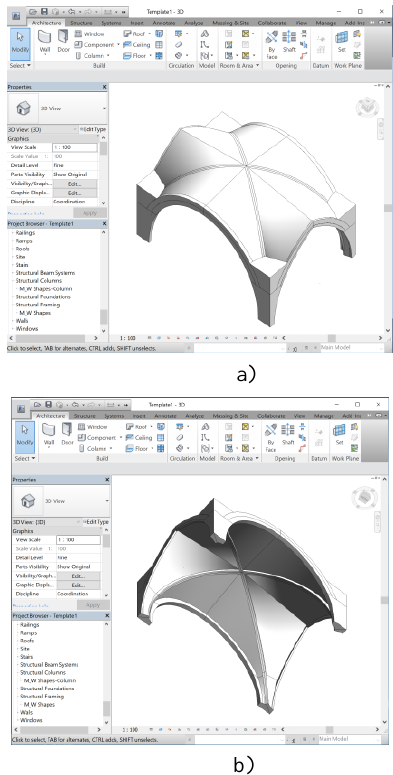
Figure 6. Masonry vault in the church of St. Bassiano: